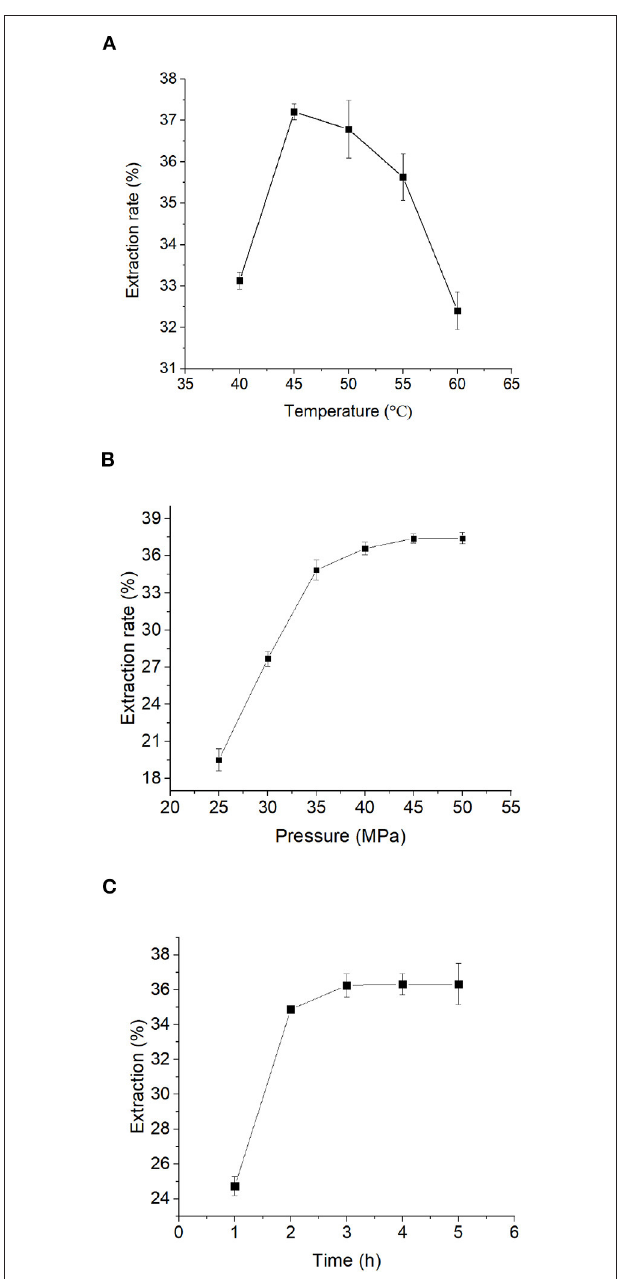
FIGURE 1 | Single factor test: Influence of (A) temperature, (B) time, and (C) pressure on the extraction rate of Moringa seed oil. Data were expressed as mean ±